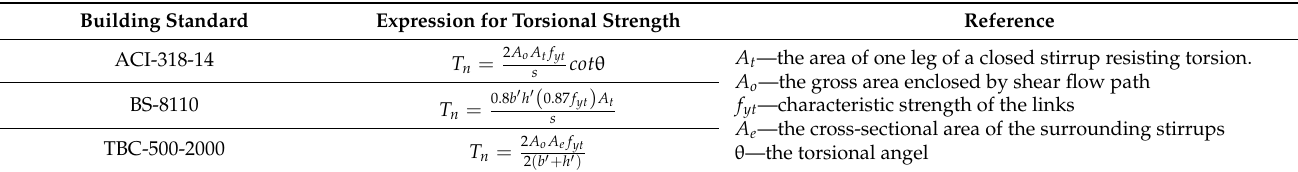
Table 3. Building standards expression of torsional strength.